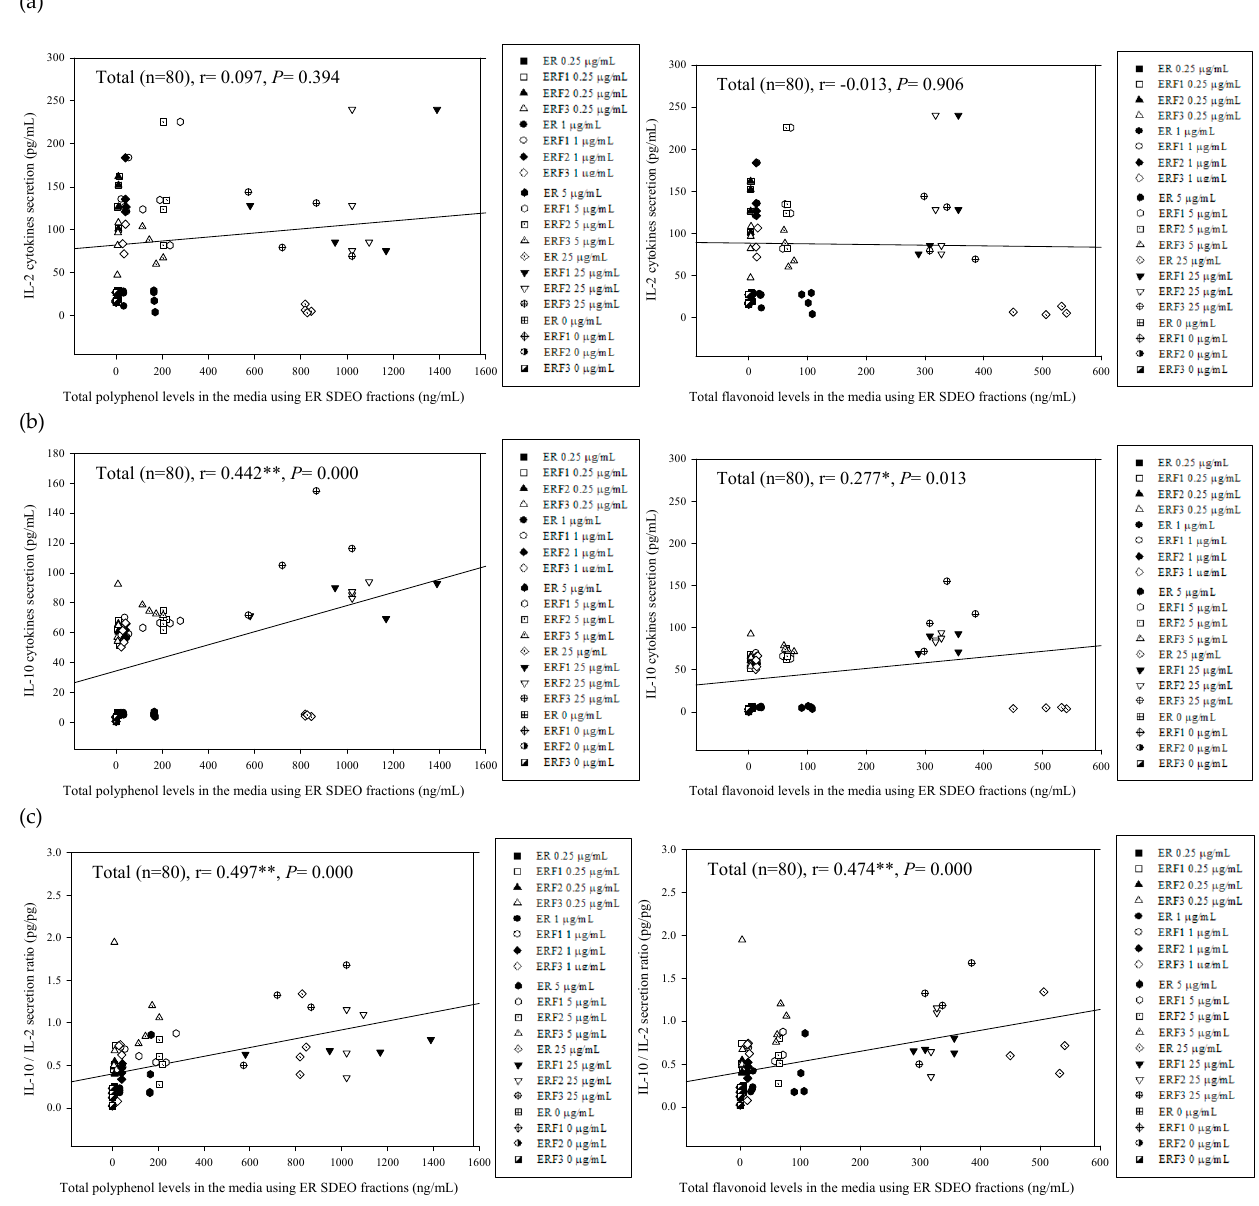
Figure 7. The associations between total polyphenol and flavonoid contents in the media using ER SDEO as well as ERF1–F3 and IL-2 ( a ), IL-10 ( b ), as well as IL-10/IL-2 cytokine secretion ratios ( c ) by splenocytes. The correlation was expressed by Pearson product–moment correlation coefficient (r). * p < 0.05; ** p < 0.01. 3.7. Associations between PC-3 Cell Viabilities Treated with SCM and Cytokine Secretion Levels in Their Corresponding SCM To clarify the relationship between cytokine secretion profiles in SCM and viabilities of PC-3 cells treated with SCM without or with ER SDEO and its isolated fractions ERE1-